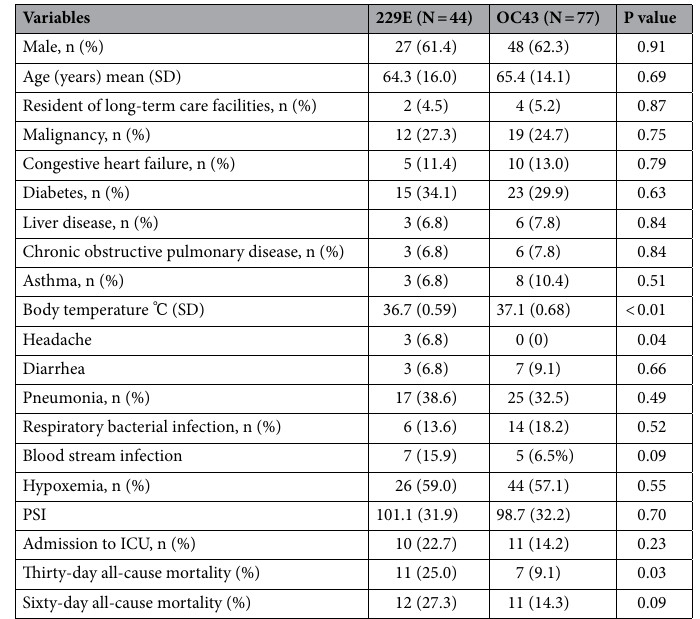
Table 1. Characteristics, comorbidities, complications, and outcomes of patients infected with human coronavirus 229E and OC43, October 2012 to December 2017. PSI pneumonia severity index, ICU intensive care unit, SD standard deviation.